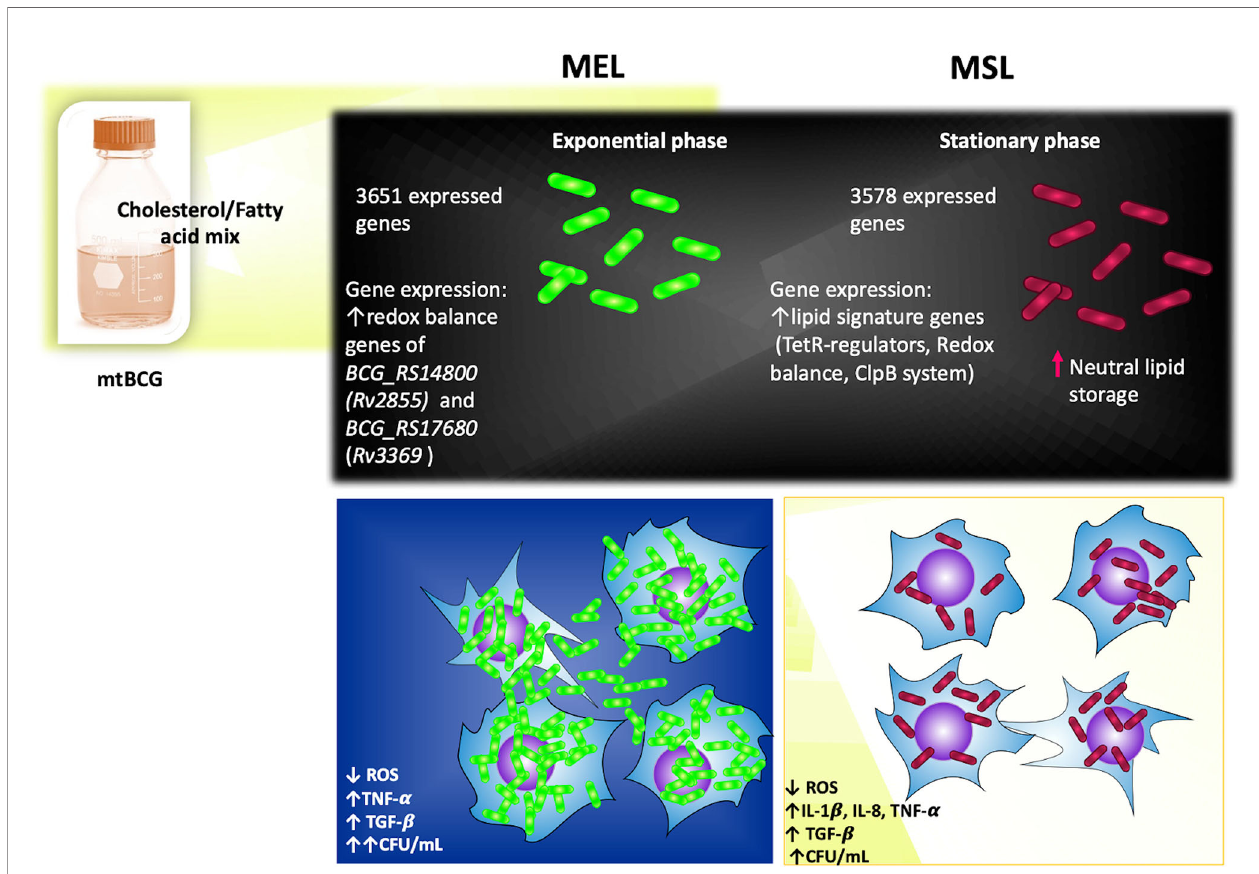
FIGURE 11 | Effects of lipids and BCG _ 2177c gene inactivation on the physiology of M. bovis BCG (Summary). See the text in Discussion (in the summary paragraph) for